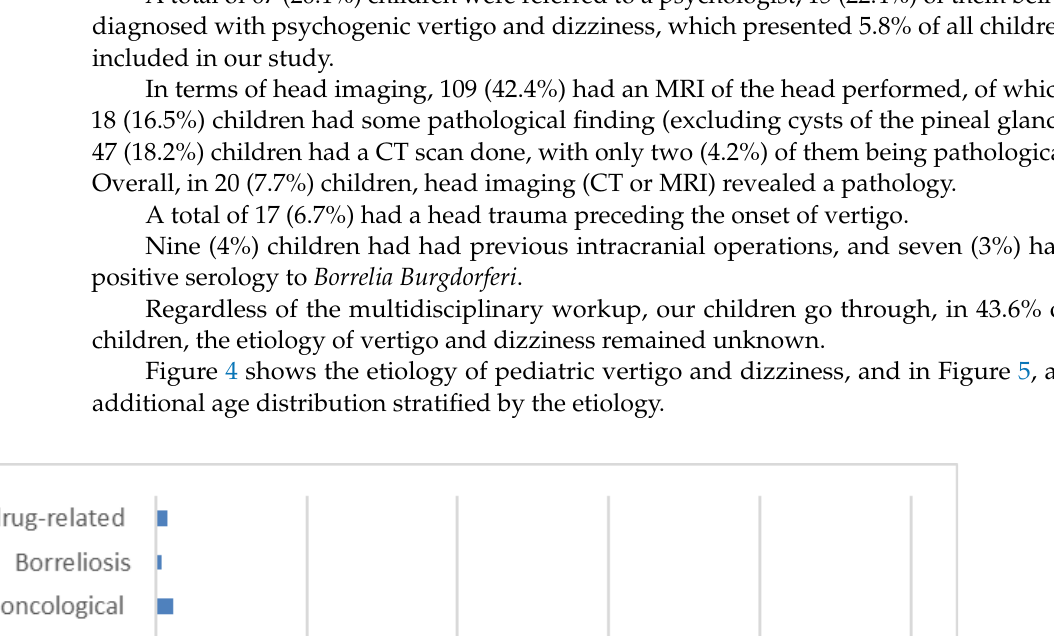
Figure 3. Flowchart showing the number of children that were referred through each of the sub-specialties.